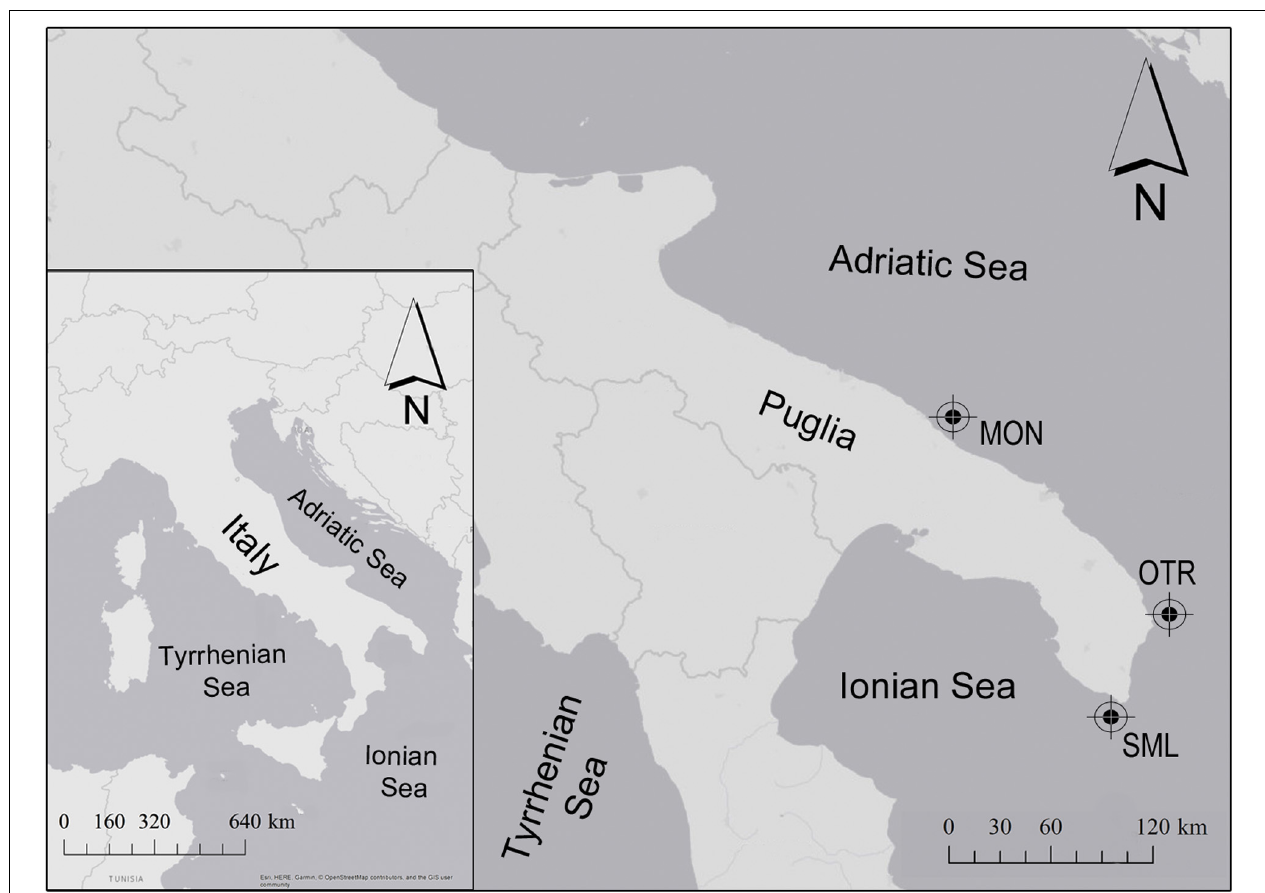
FIGURE 1 | Map of the geographic location of the three mesophotic investigated habitats: Monopoli (MON), Otranto (OTR), and Santa Maria di Leuca